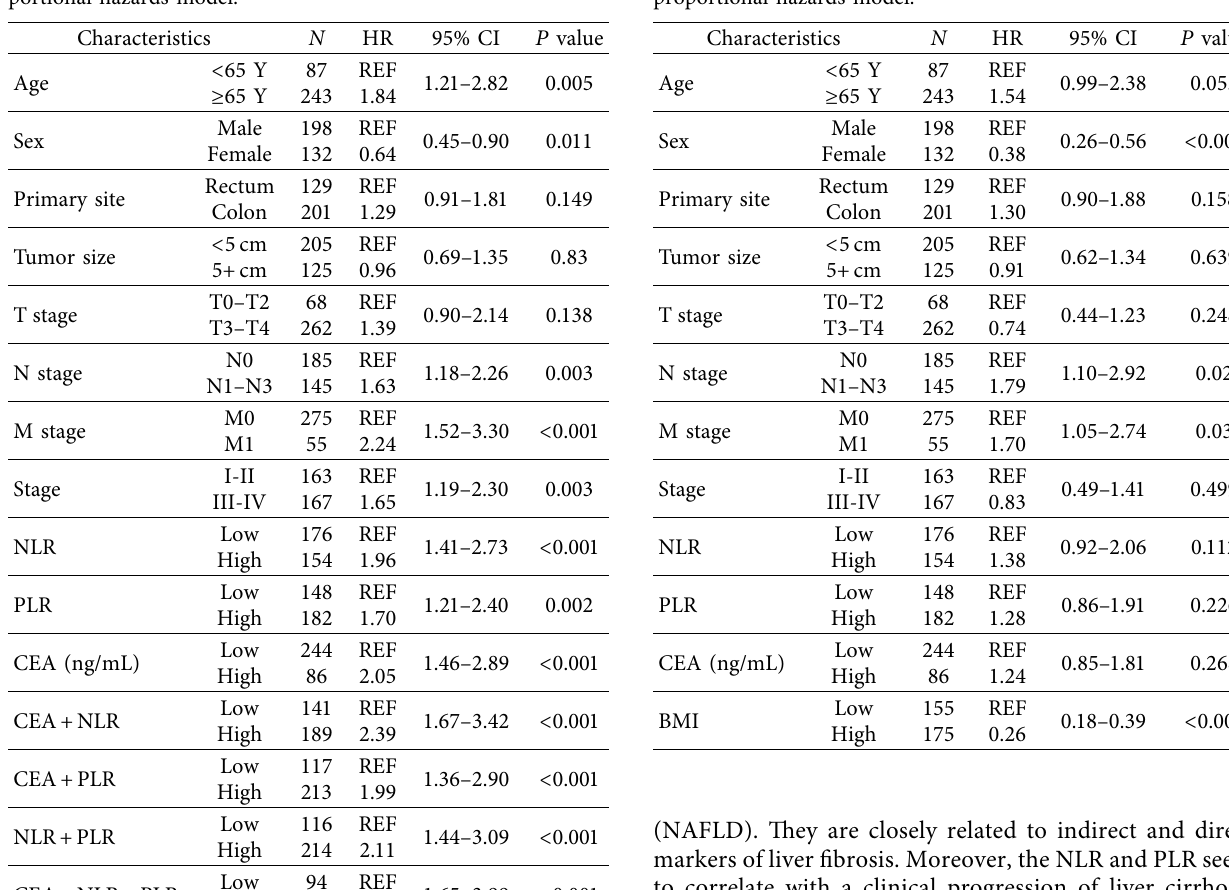
Table 4: Univariate analysis of overall survival by the Cox pro- portional hazards model.